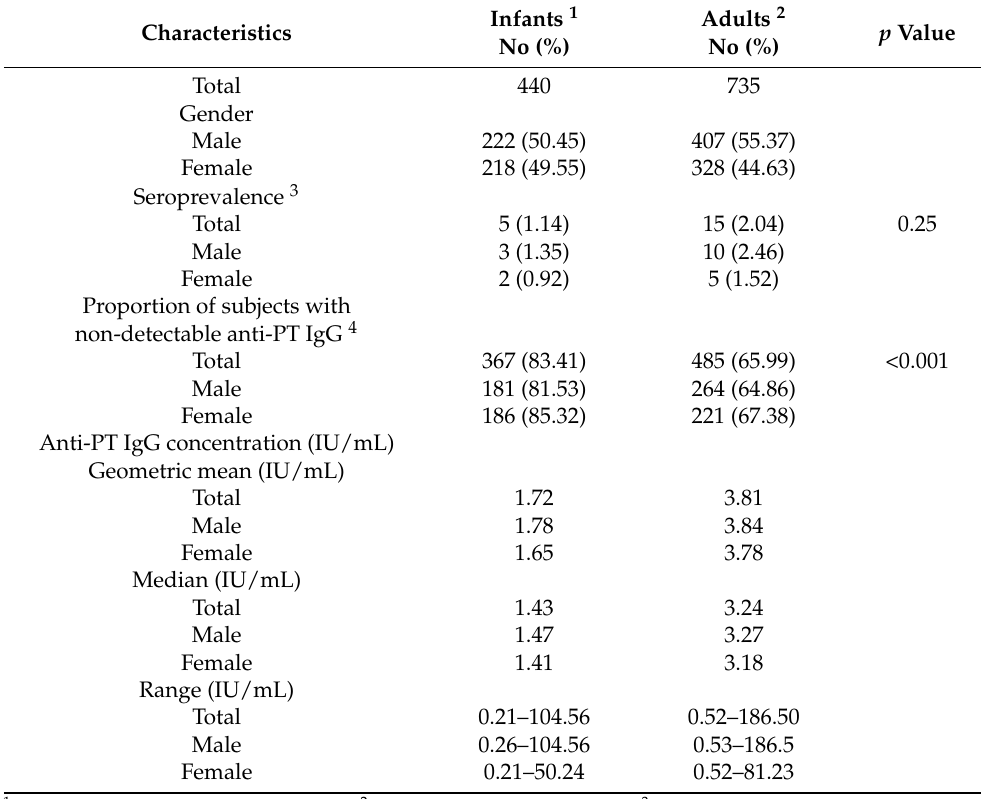
Table 1. Characteristics of 1175 study subjects and their serum anti-PT IgG antibodies.